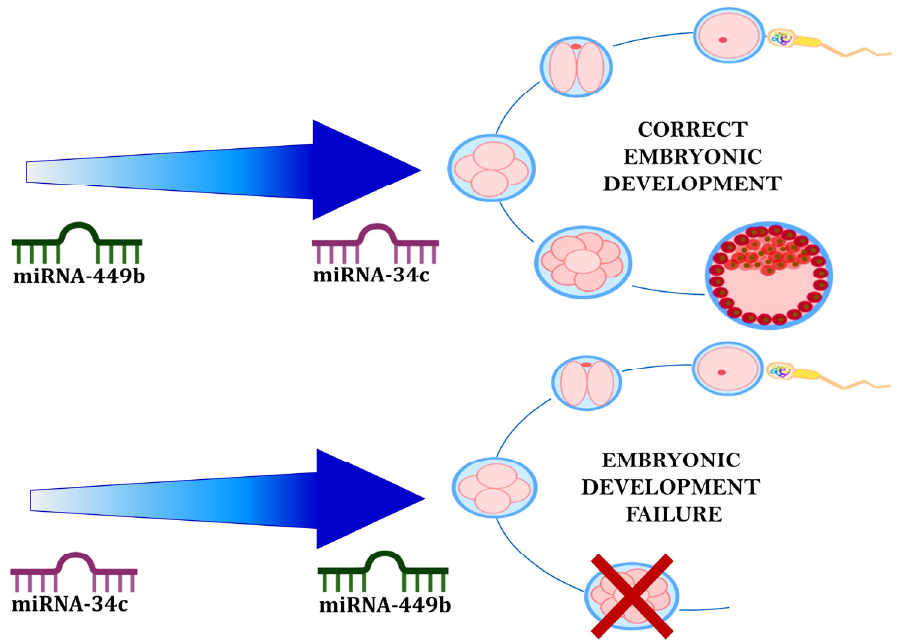
Figure 4. Hypothesis of the combined effect of the investigated miRNAs (miR-34c-5p and miR-449b-5p) on the embryonic development. The color intensity in the arrows corresponds to different behavior of miR-449b-5p and miR-34c-5p in the spermatozoon. The upper arrow represents the condition where there is a lower level of miR-449b-5p compared to miR-34c-5p; the lower arrow corresponds to the condition where there is a lower level of miR-34c compared with miR-449b. The lighter part of the arrow corresponds to lower levels of a miRNA compared to the other and the darker part indicates the increased level.